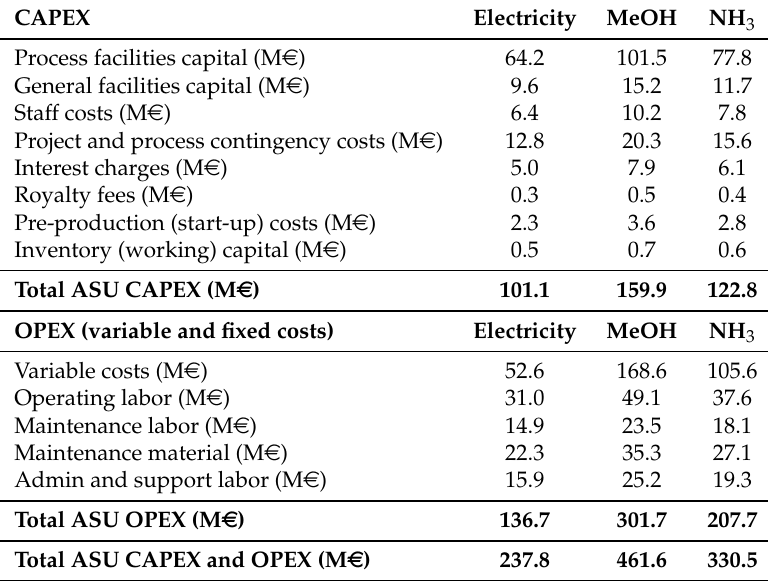
Table 8. Air separation costs in the onshore/offshore reference scenarios with an air feed demand of 70 kg/s for onshore electricity production, as well as 222 and 139 kg/s for onshore/offshore methanol and ammonia production for 20 years of operation, modeled with IECM